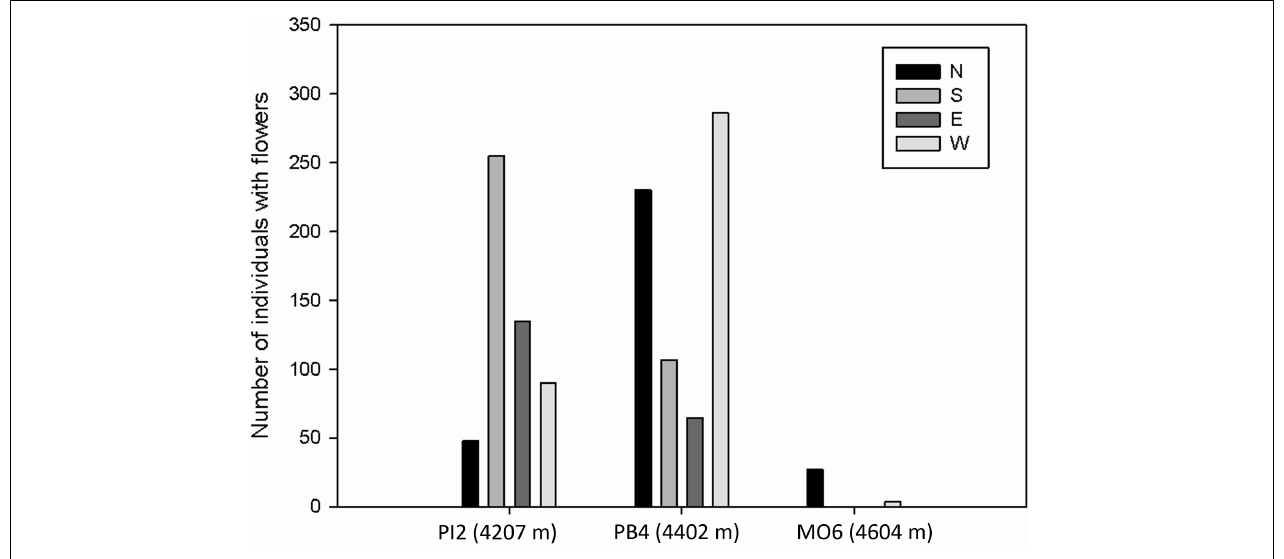
FIGURE 4 | Number of individuals with flowers in each cardinal orientation in the summits of the GLORIA–Andes network (VE-CPB site), at La Culata National Park, Piedras Blancas Páramo,